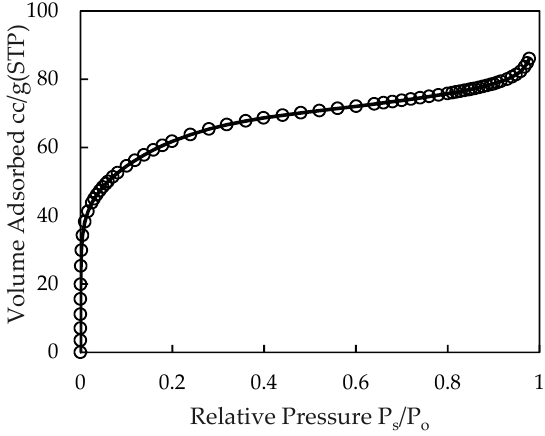
Figure 5. Adsorption isotherm of N 2 onto synthesized nano-alumina.